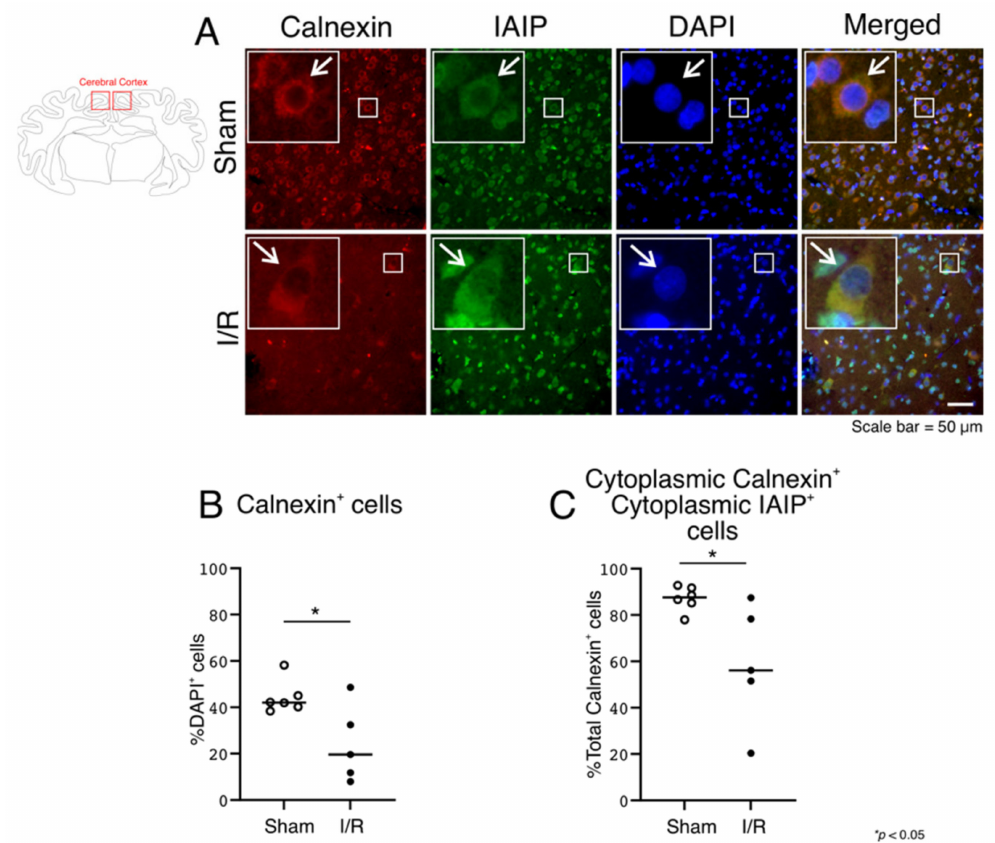
Figure 8. Co-localization of IAIPs with the endoplasmic reticulum in cytoplasm in the cerebral cortex. Schematic diagram of a sheep brain indicates the regions from which cerebral cortical samples were taken. ( A ) Representative images of calnexin-positive endoplasmic reticulum (Red), IAIPs (Green), DAPI-positive cells (Blue), and merged double immunostaining in the cerebral cortex of fetal sheep in Sham and I/R groups. Magnification, 40 × . Each inset contains the extended images. Scale bar = 50 µ m. Arrows indicate the same cell. ( B ) Quantification of calnexin-positive stained cells. IAIP-positive calnexin-positive cells plotted as a percentage of DAPI-positive cells on the y-axis for Sham (open circles) and I/R (closed circles). Values median and scattergrams. ( C ) IAIP positive and calnexin positive cells on the y-axis plotted as a percentage of total calnexin-positive cells for cytoplasmic compartments for Sham (open circles) and I/R (closed circles) groups plotted on the x-axis. Values median and scattergrams. * p < 0.0280